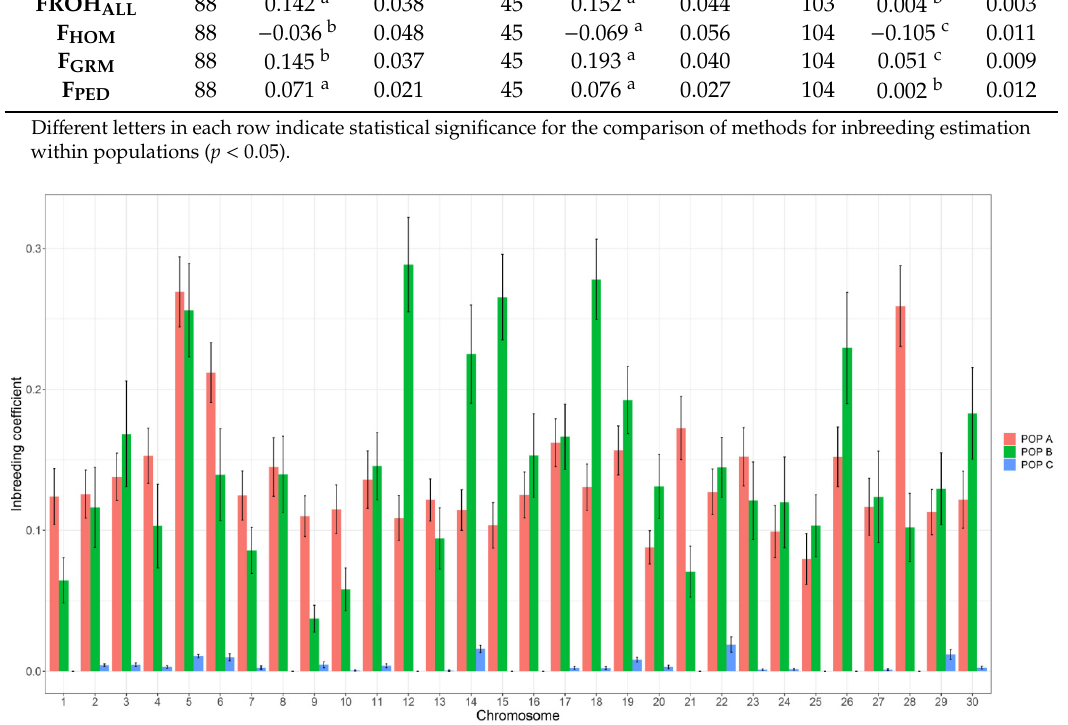
Figure 5. Distribution of average inbreeding coefficients estimated using ROH for each chromosome in three coho salmon populations. Standard error bars were computed among individuals from the same population.